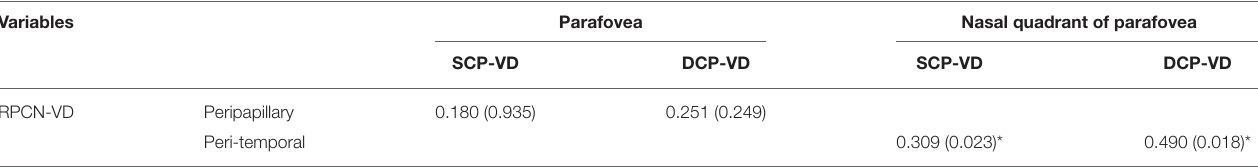
TABLE 6 | The Results of Pearson Correlation Analyses between RPCN and Parafoveal Vascular Densities in BU Group. Variables